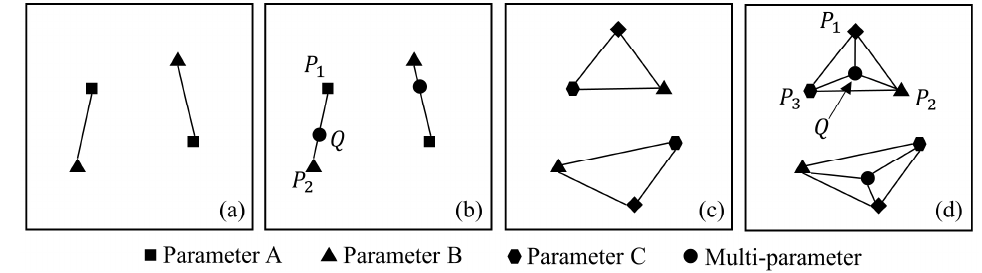
Figure 3. Adaptive weighted space in multiparameter sampling design ( a – d